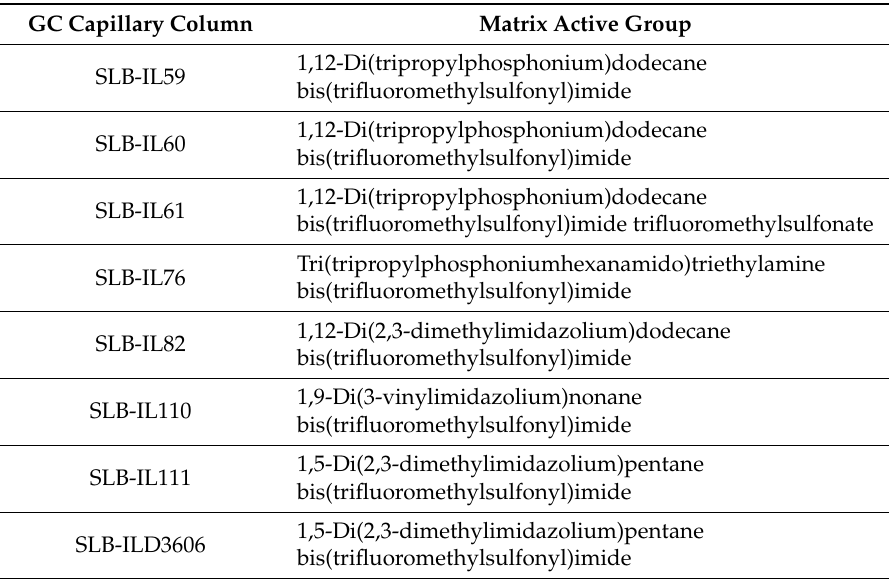
Table 4. Selected commercial IL capillary GC columns with matrix active